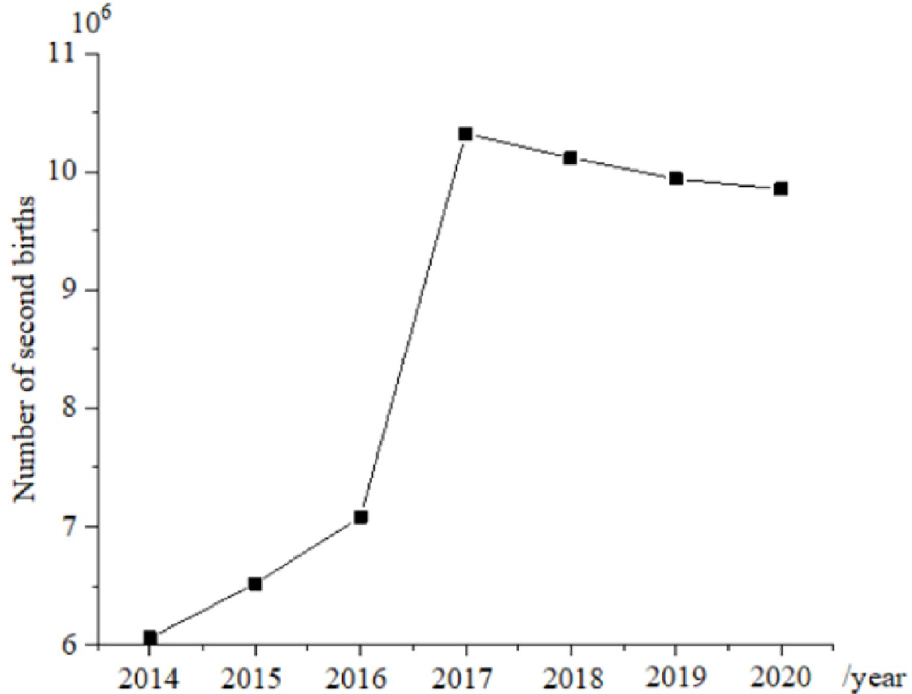
Fig 3. Number of second births during